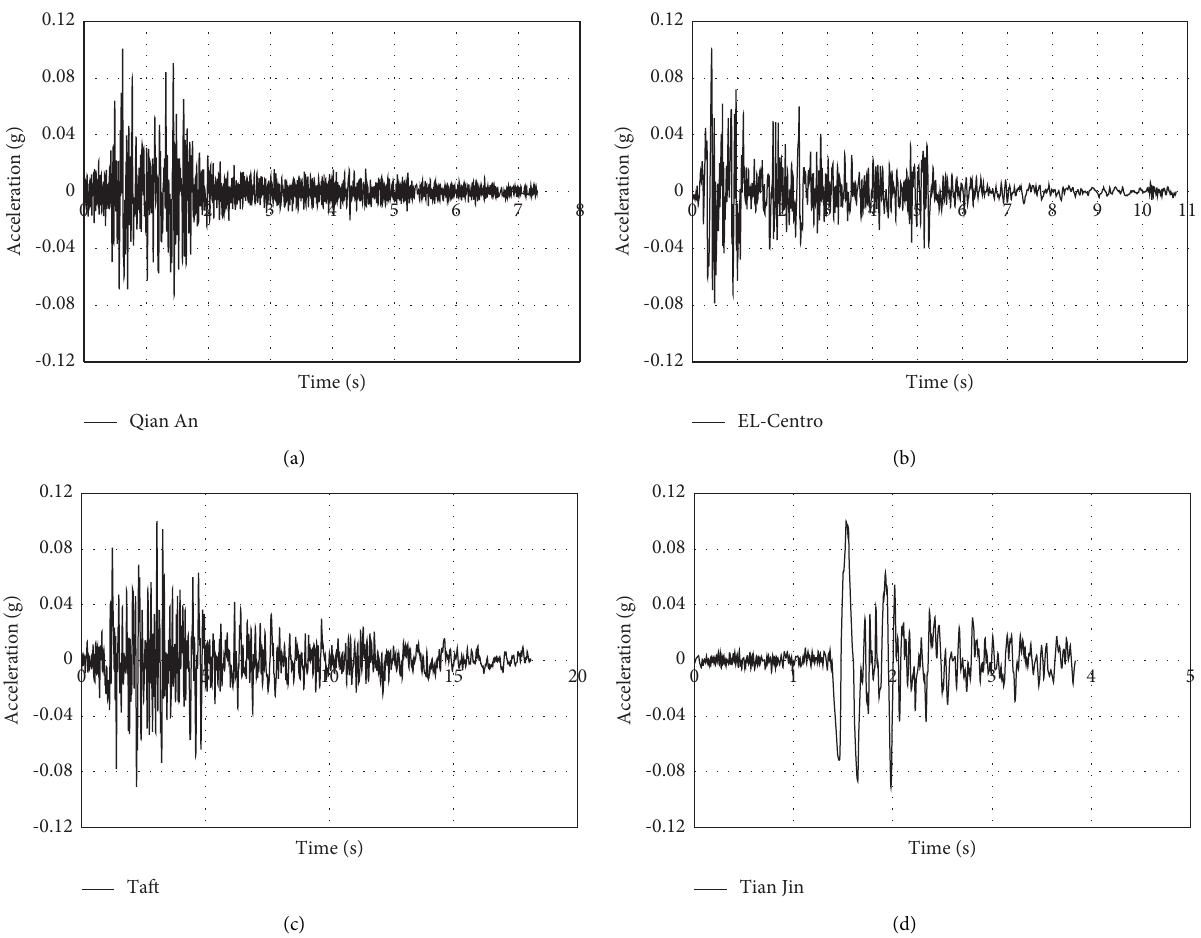
Figure 5: Time history curve of diferent ground motions: (a) Qian An, (b) EL-Centro, (c) Taft, and (d) Tian